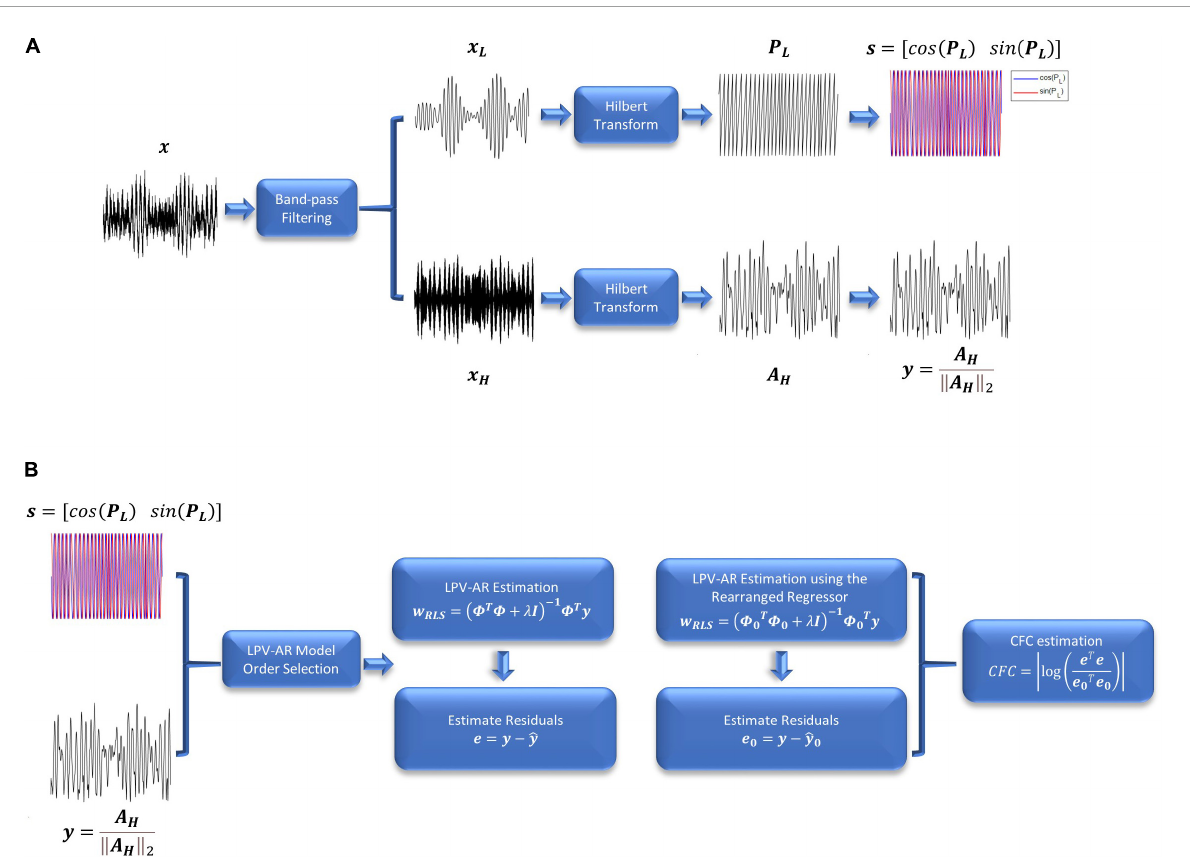
FIGURE1 (A) Preprocessing steps and (B) LPV-AR identification for CFC quantification. (A) The signal of interest is first band-pass filtered at the frequency bands L and H . After applying the Hilbert transform, the instantaneous amplitude and phase signals are used to estimate the LPV-AR based CFC. (B) LPV-AR model order selection procedure is realized as described in section “Linear parameter varying autoregressive model order selection.” LPV-AR identification is achieved by estimating the model coefficients. A new LPV-AR model is identified by rearranging the regressor matrix. CFC is quantified based on the residuals of both